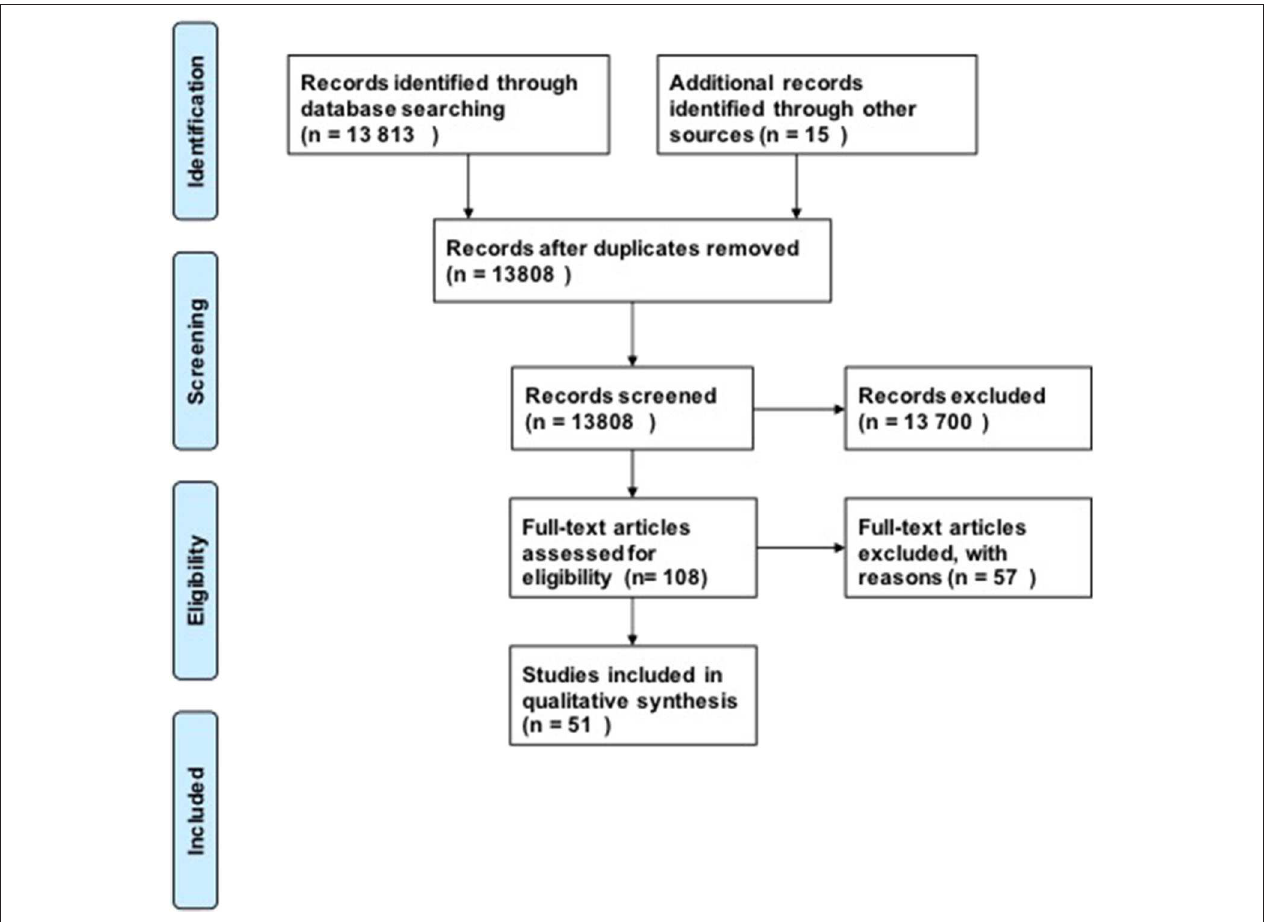
FIGURE 1 | PRISMA Flow